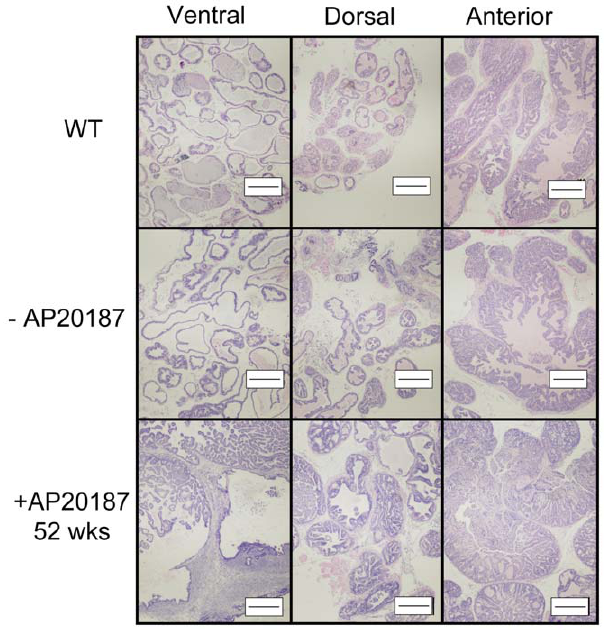
Figure 11. Invivo CID-mediated iLRP5 activation in the intact prostate results in prostate tumor development. Treatment of Ubi-Cat mice (n=6) with AP20187 starting at 6 weeks of age for 52 weeks leads to development of prostate adenocarcinoma (2 of 6). Age- matched WT and untreated Ubi-Cat prostates (n=6) appeared normal. Bar=200 m